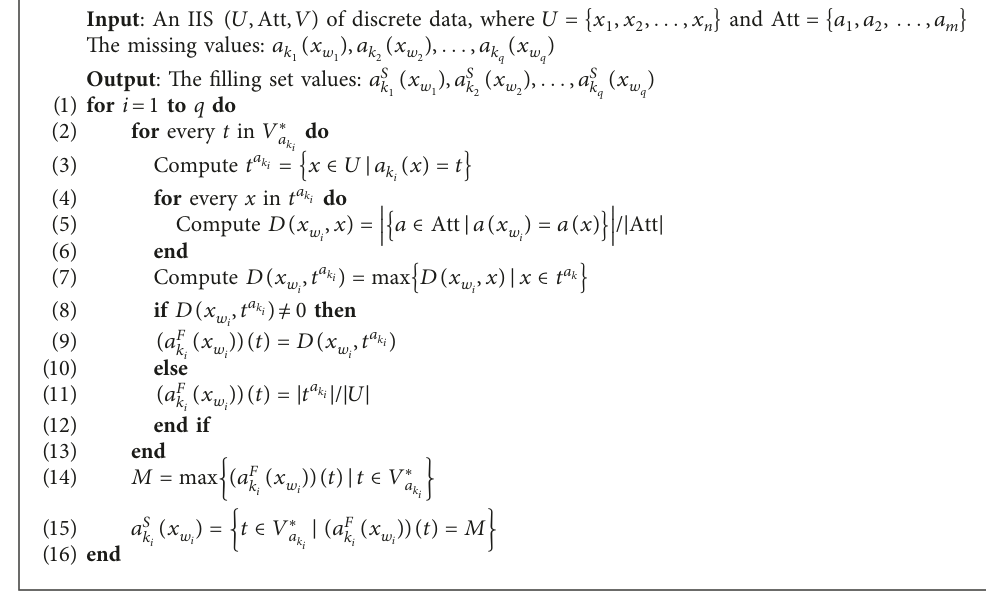
A LGORITHM 3: Algorithm FMvSV: filling the missing values with set